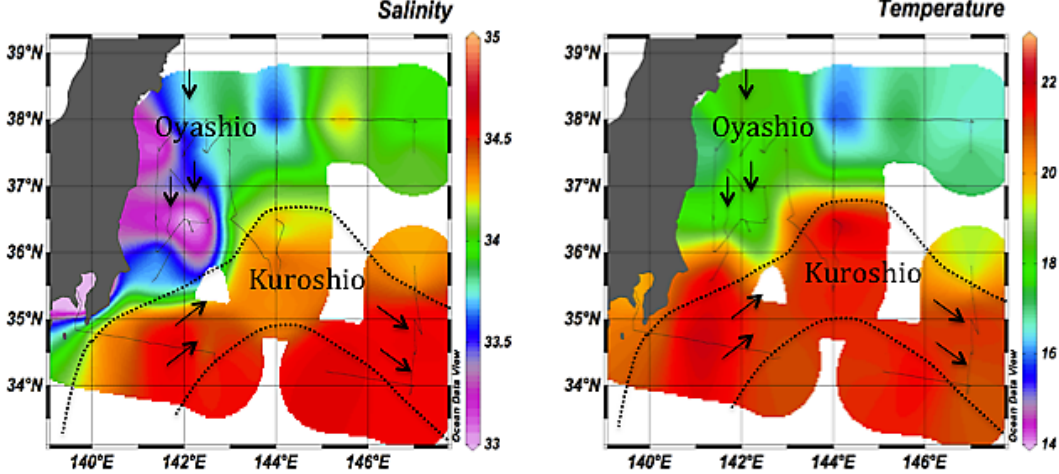
Fig. 6. Surface salinity and temperature measured during the KOK cruise in June 2011; the Oyashio and Kuroshio currents are depicted. Grey contour on the left represents the Japanese coast.